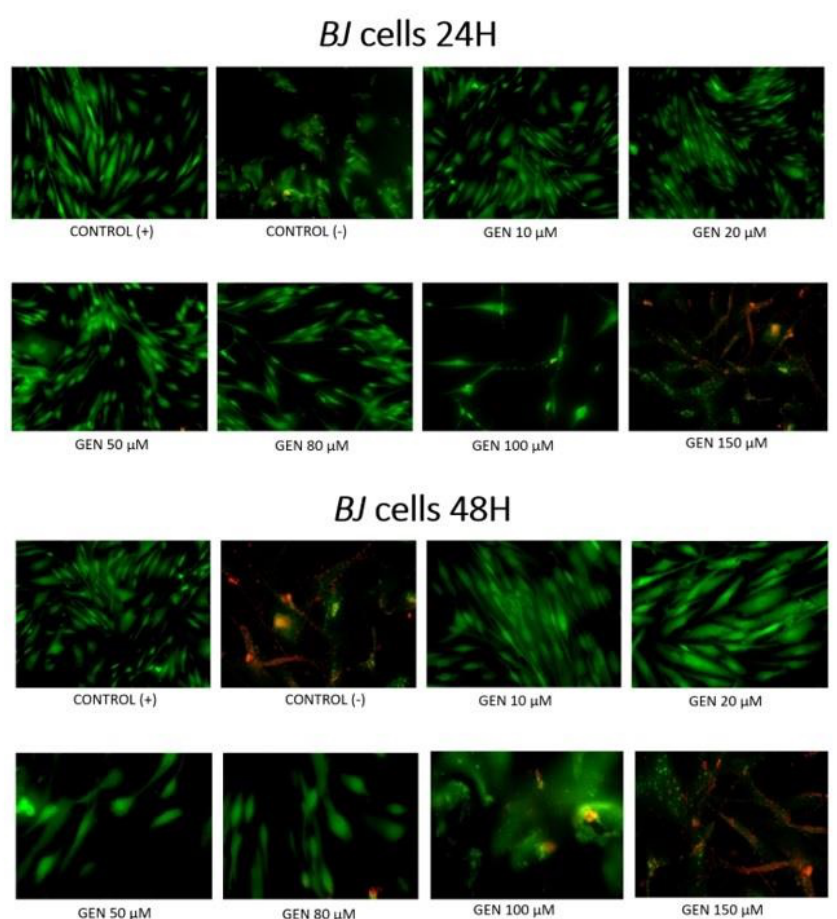
Figure 4. Induction of apoptosis by genistein at different concentrations in non-tumor BJ cell lines in fluorescent microscope (magnification 400 × ). Cells were stained with annexin-Cy3.18 (AnnCy3) and 6-Carboxyfluorescein diacetate (6-CFDA). AnnCy3 binds to phosphatidylserine present in the outer leaflet of plasma membrane of cells starting the apoptotic process. The binding is observed as red fluorescence. 6-CFDA is used to measure viability. When this non-fluorescent compound enters living cells, esterases hydrolyze it, producing fluorescent compound 6-carboxyfluorescein (6-CF). This appears as green fluorescence. Cells cultured with 0.1% DMSO were considered Control (+). Cells cultured with 15% DMSO were considered Control ( − ).